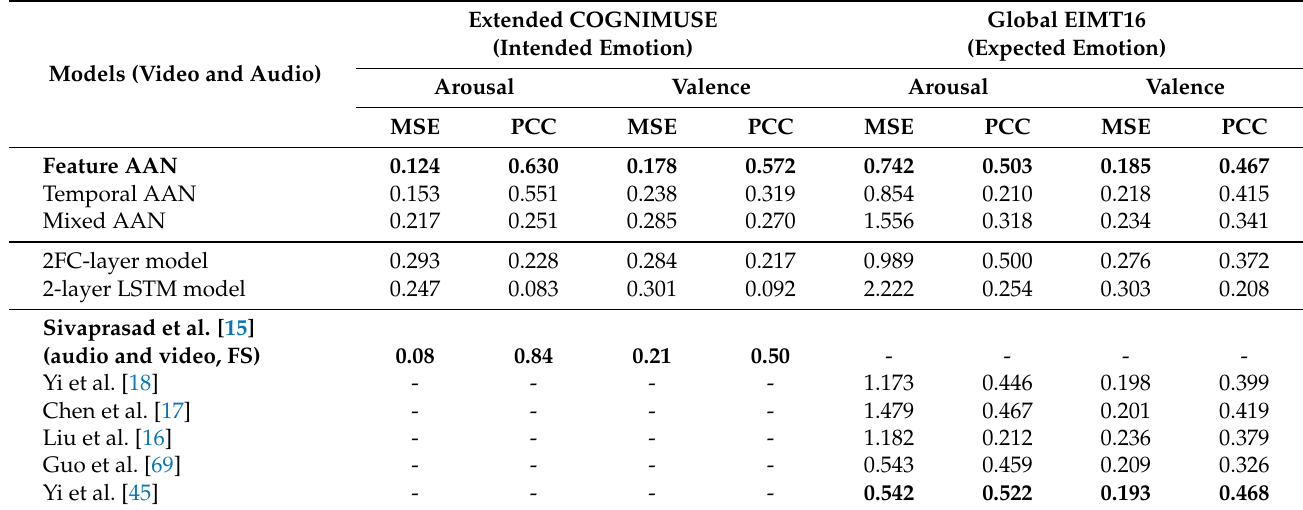
Table 4. The performance of our models using both visual and audio features. FS denotes feature selection.